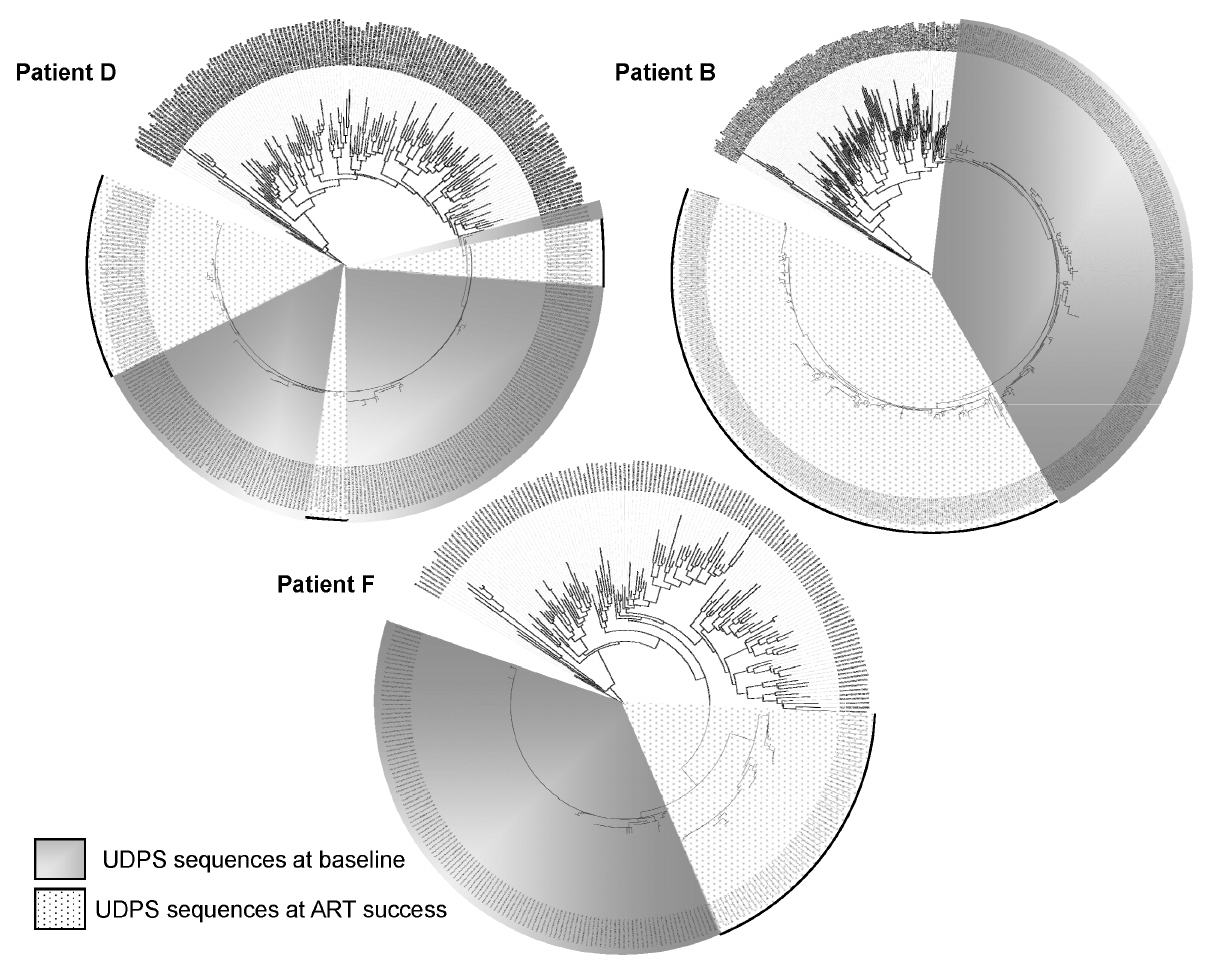
Figure 1. Phylogenetic trees of UDPS sequences (Pol RT2) at baseline and at ART success. Patients D, B and F according to Table 1.